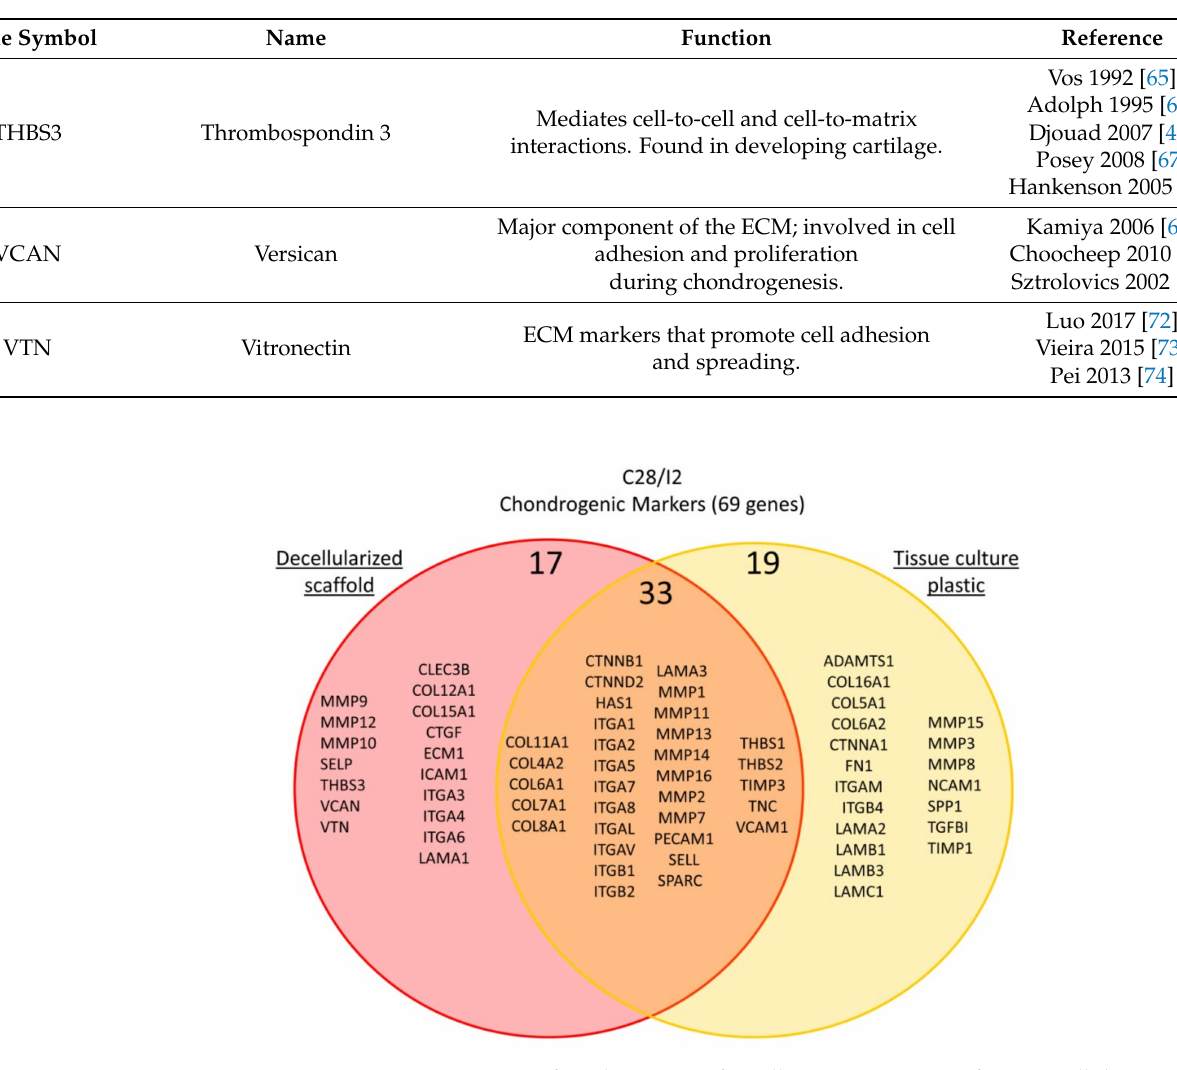
Figure 10. Gene expression of markers in C28/I2 cells. Gene expression for extracellular matrix, cell adhesion molecules, and cell–cell attachment proteins was measured by quantitative real-time PCR. The venn diagram clusters genes with respect to upregulation in cells grown on conventional tissue culture plastic shown in yellow, in cells grown on the decellularized cartilage scaffold shown in pink. Genes that were upregulated under both conditions are shown in the orange overlap region of the Venn